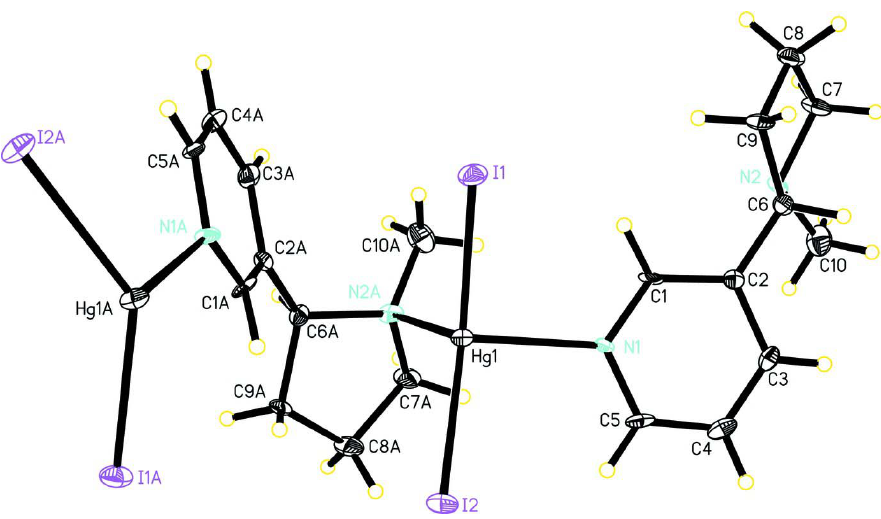
Figure 1 Molecular structure of the title compound, with atom labels and 50% probability displacement ellipsoids. All H atoms have been omitted. Symmetry transformations: A is -x+1/2, -y, z+1/2. catena-Poly[[diiodidomercury(II)]- µ -3-(1-methyl-2-pyrrolidinyl)pyridine- κ 2 N:N ′